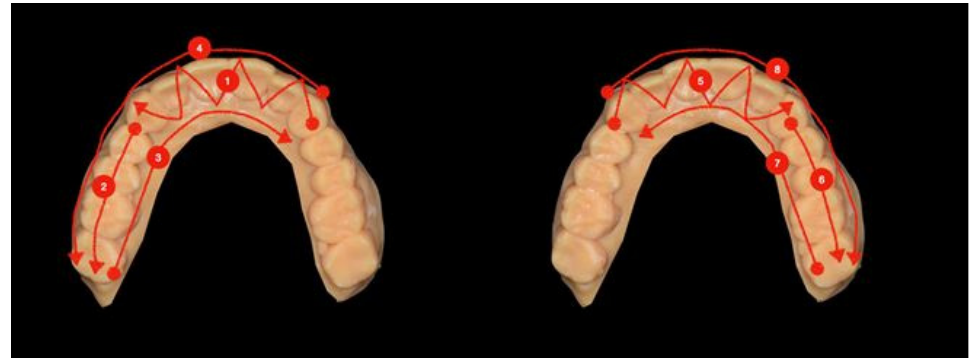
Figure 2. The path of the scan in the second strategy. Two different tips (old tip and new tip) and the first strategy were used to scan the model with the IOS; the old tip was also used to scan the model with the second strategy.